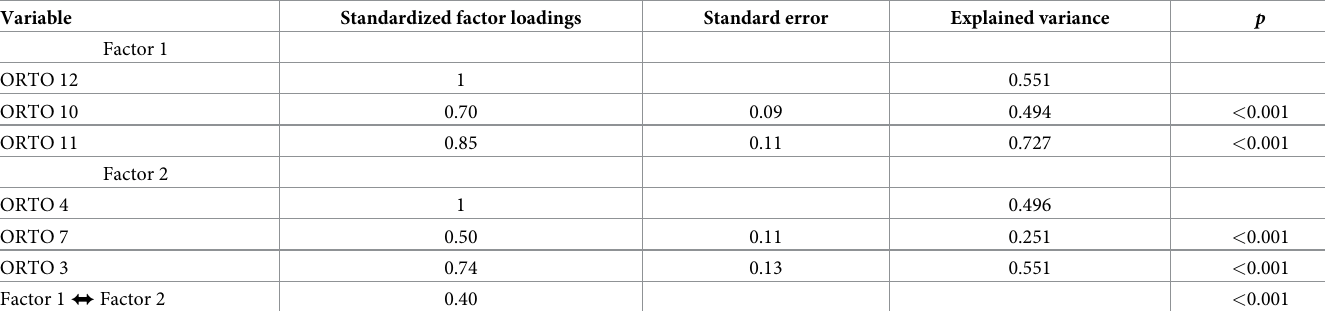
Table 3. Item descriptive statistics, standardized factor loadings, and explained variance of the ORTO-R.